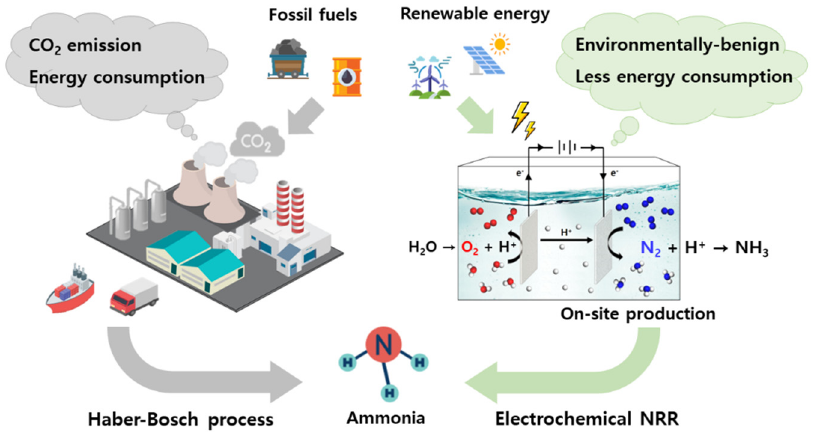
Figure 1. Schematic illustration for comparing the HB and NRR processes.